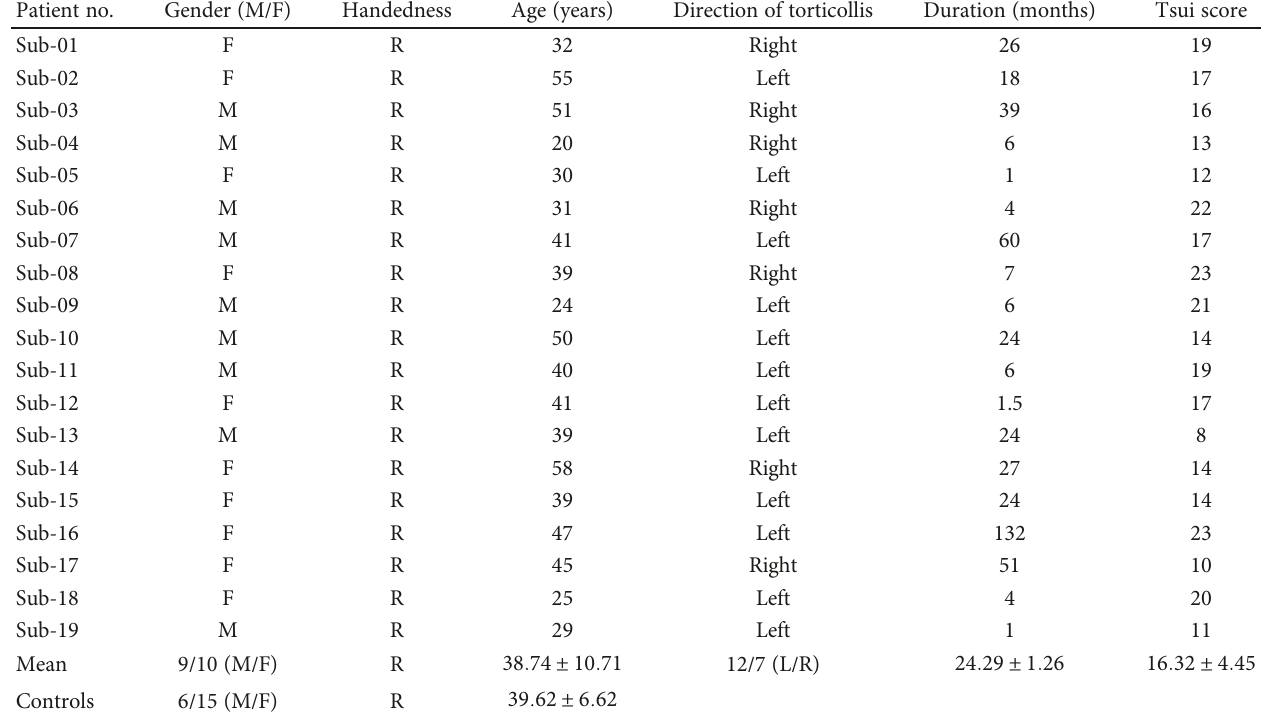
Table 1: Clinical characteristics of 19 CD patients and 21